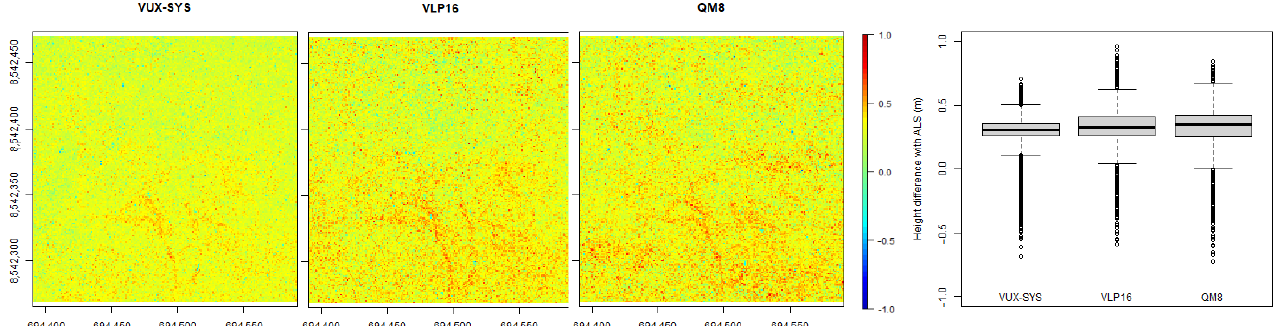
Figure 7. ( Left ) Digital terrain models acquired with the different sensors; elevation is given in metres above sea level. ( Right ) Canopy height models acquired with the different sensors; elevation is given in metres above the terrain. The area shown covers the 200 × 200 m study area; coordinates on the x and y axes are given in UTM Zone 52S.